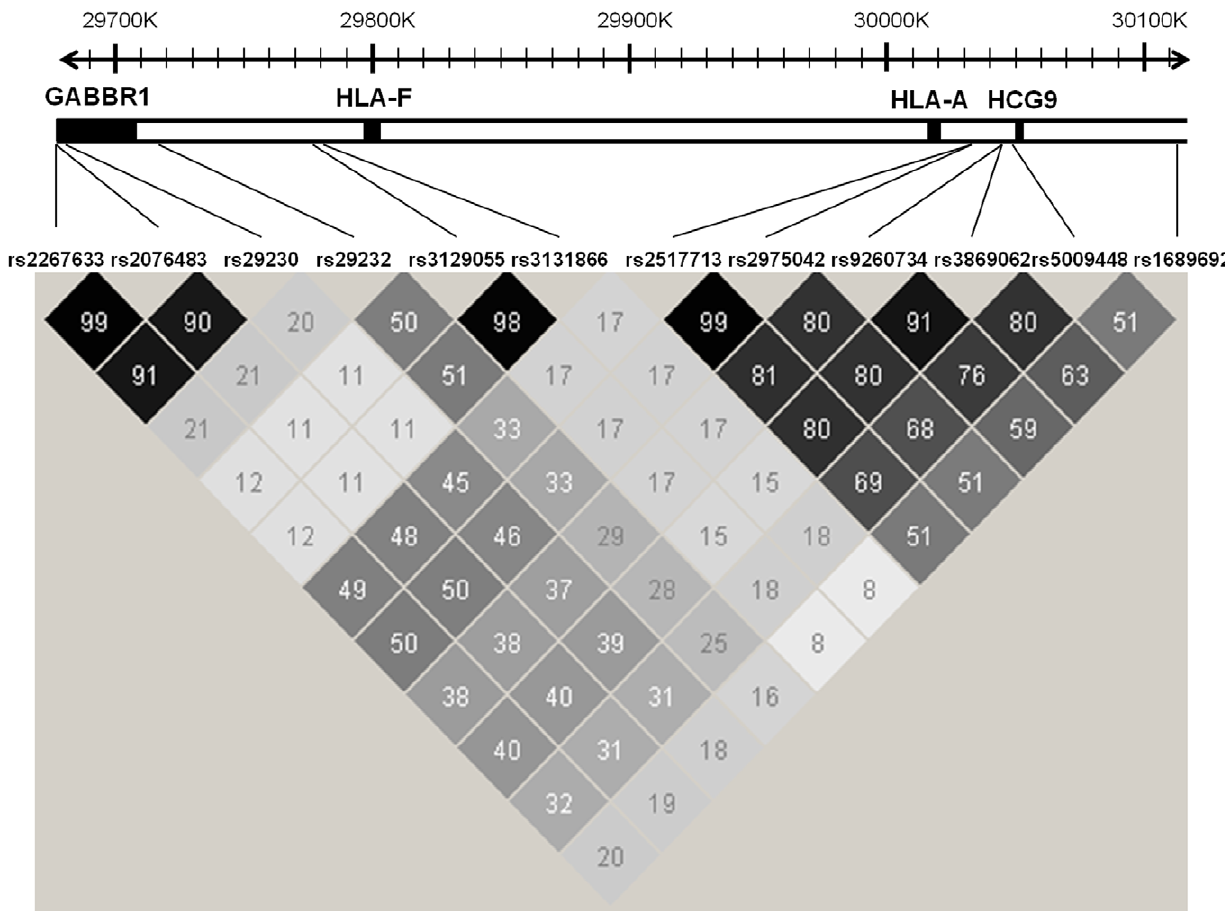
Figure 1. Haploview Map Showing Location and R-squared for 12 Markers Selected for Study.